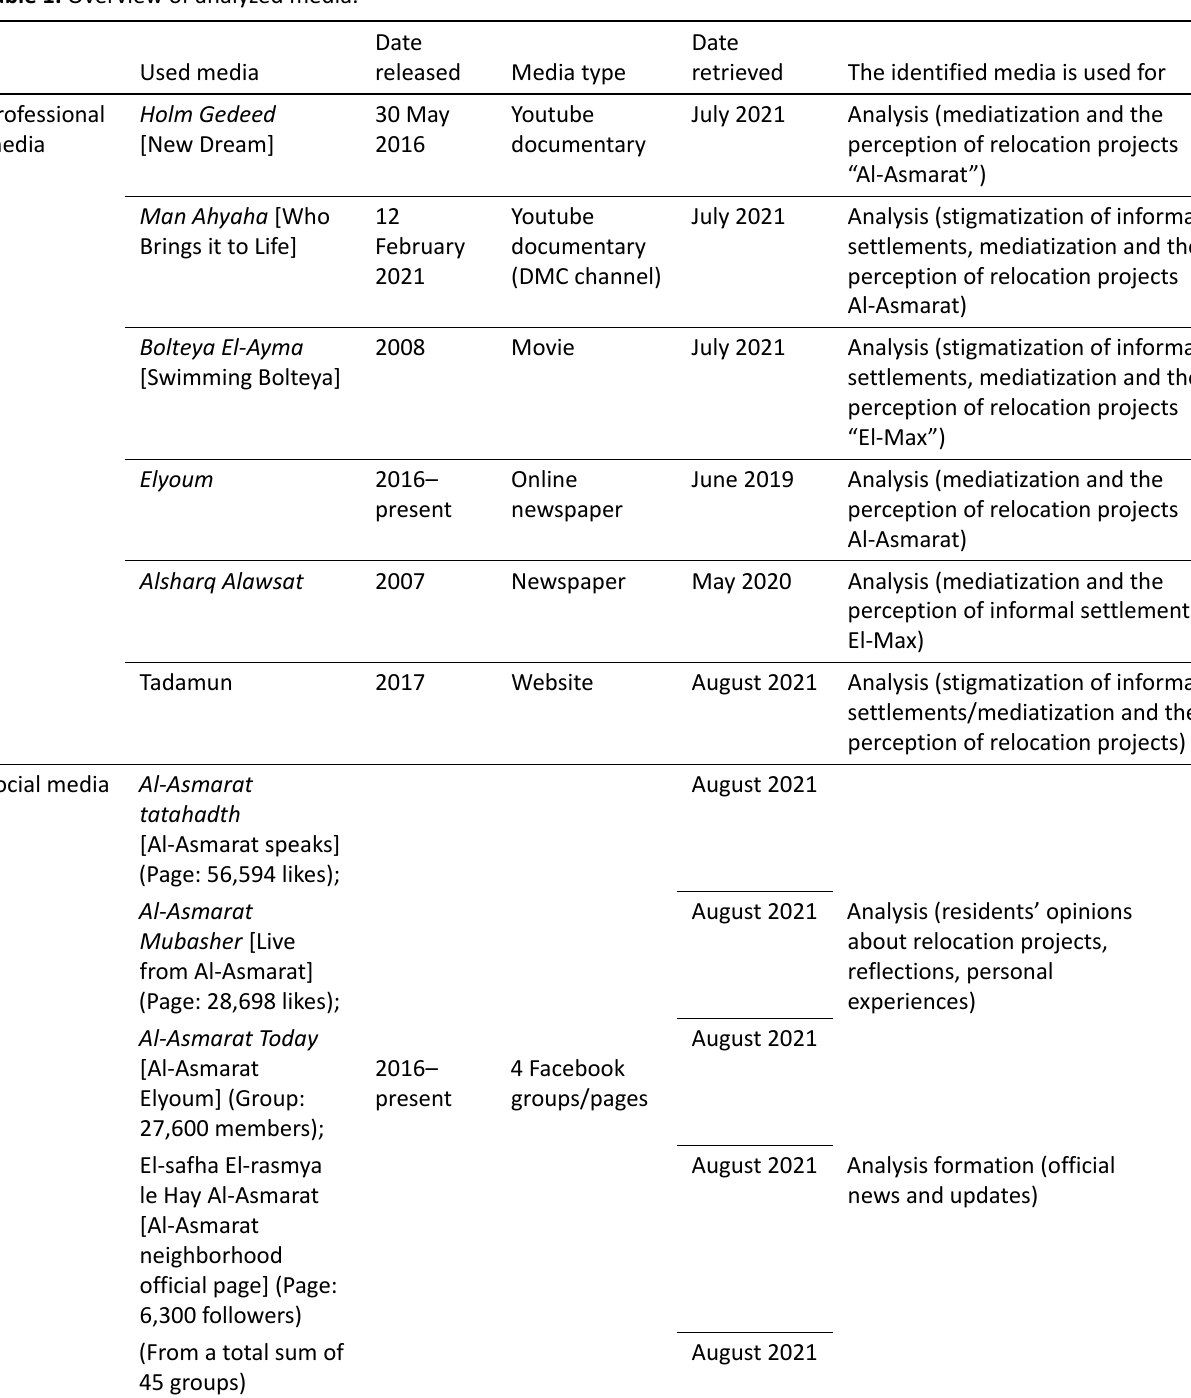
Table 1. Overview of analyzed